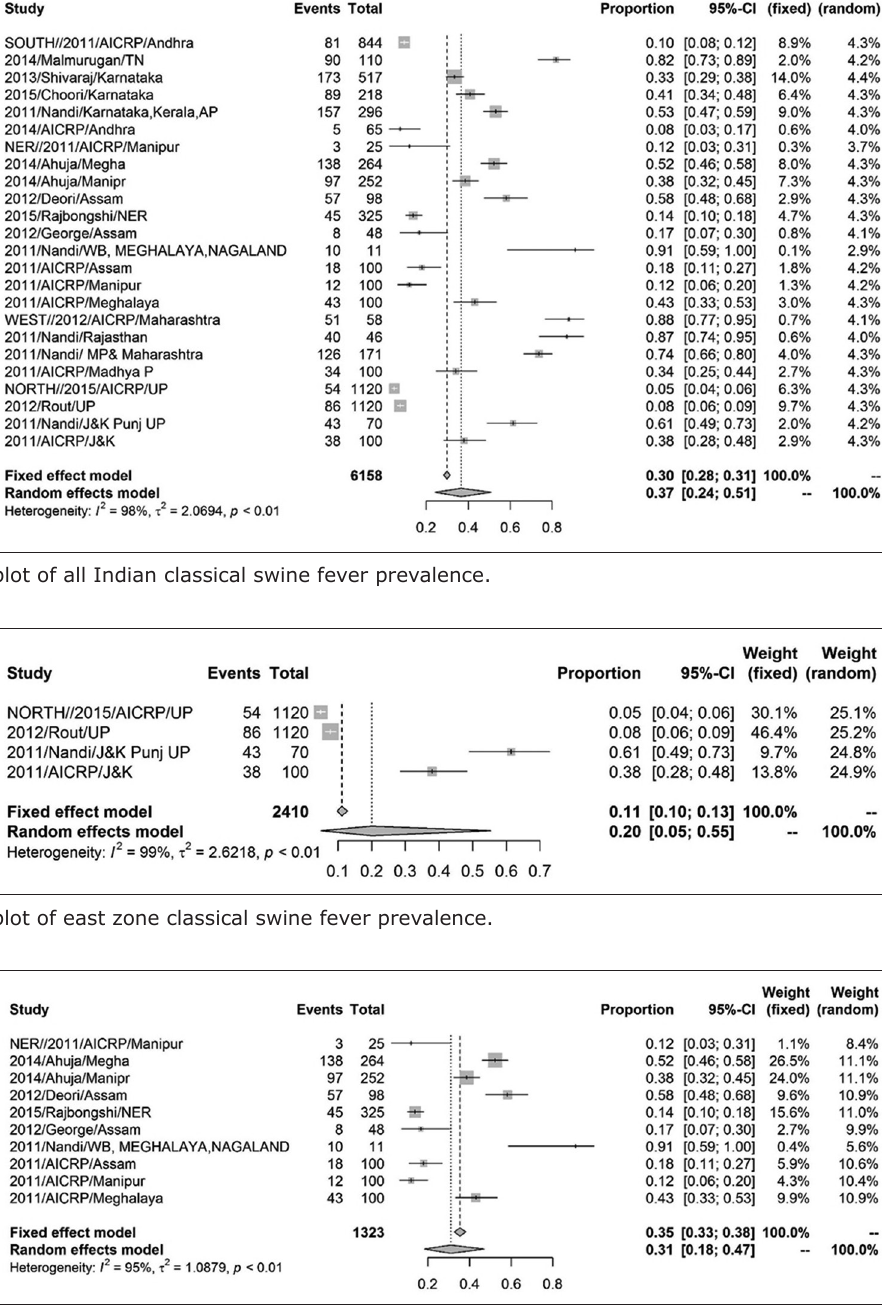
Figure-4: Forest plot of west zone classical swine fever